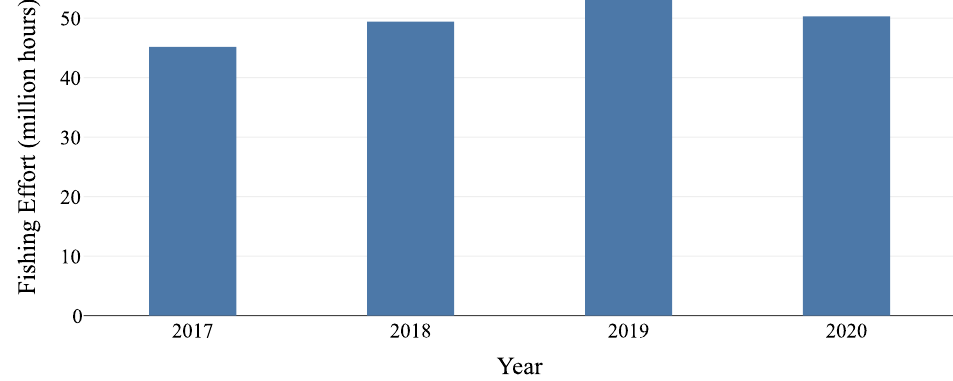
Figure 2. Global fishing effort from 2017 to 2020.